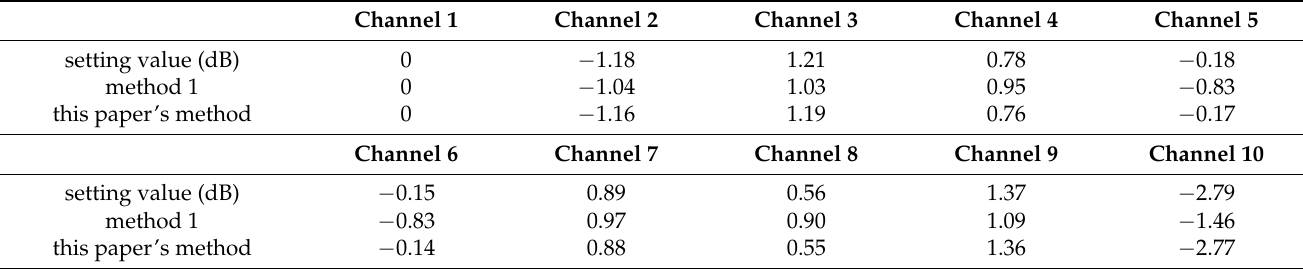
Table 4. Amplitude bias estimation of multiple-channels SAR.